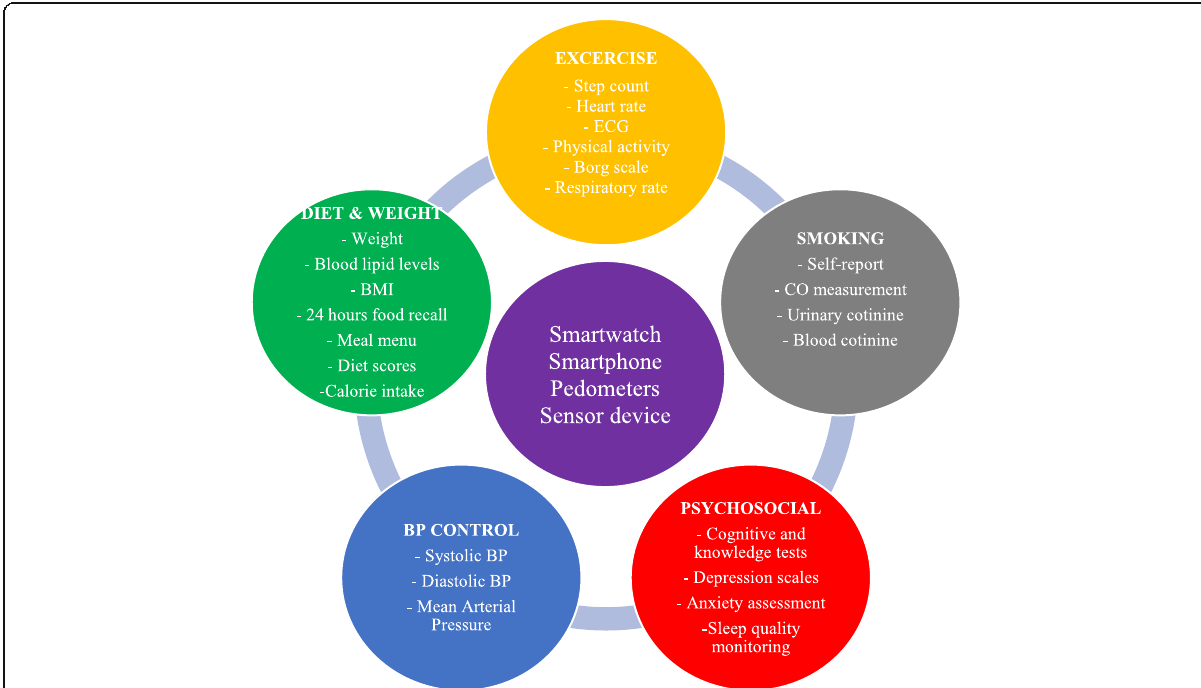
Fig. 2 Monitoring devices and parameters of telerehabilitation [23]. BP, blood pressure; CO, carbon monoxide; BMI, body mass index; ECG,